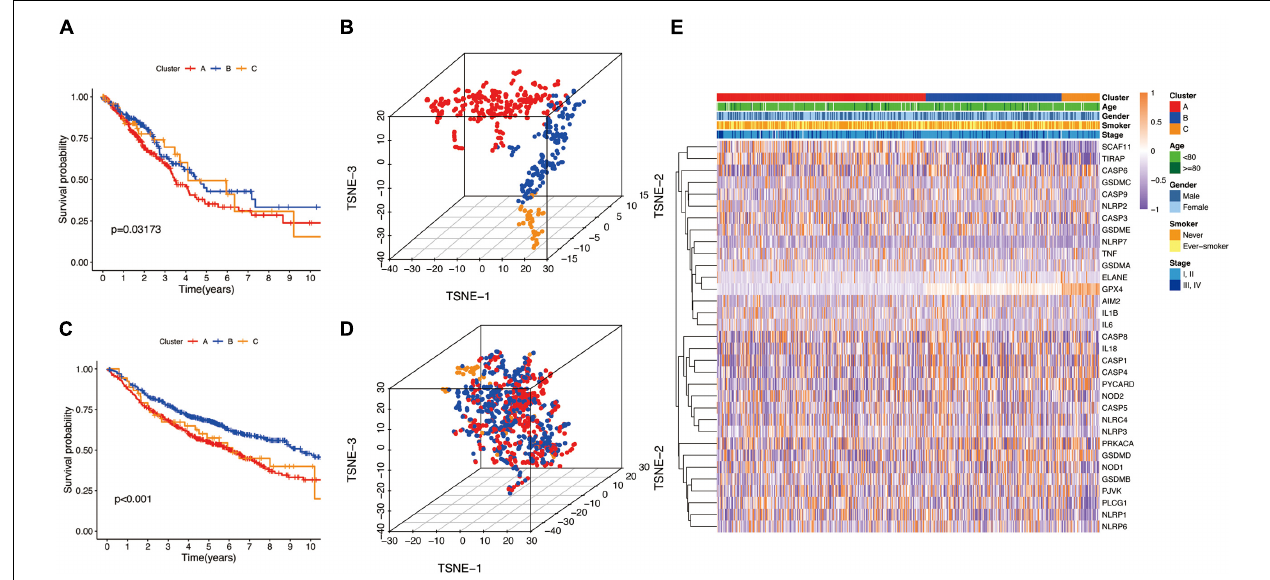
FIGURE 3 | The landscape of pyroptosis-related LUAD subtypes. (A,C) Kaplan Meier analysis of three molecular subtypes in the TCGA and GEO cohort, respectively. (B,D) t-distributed stochastic neighbor embedding (t-SNE) analysis in the TCGA and GEO cohort, respectively. (E) Heat map of the expression profile of pyroptosis-related genes and the distribution of clinicopathological parameters in all three subtypes in TCGA